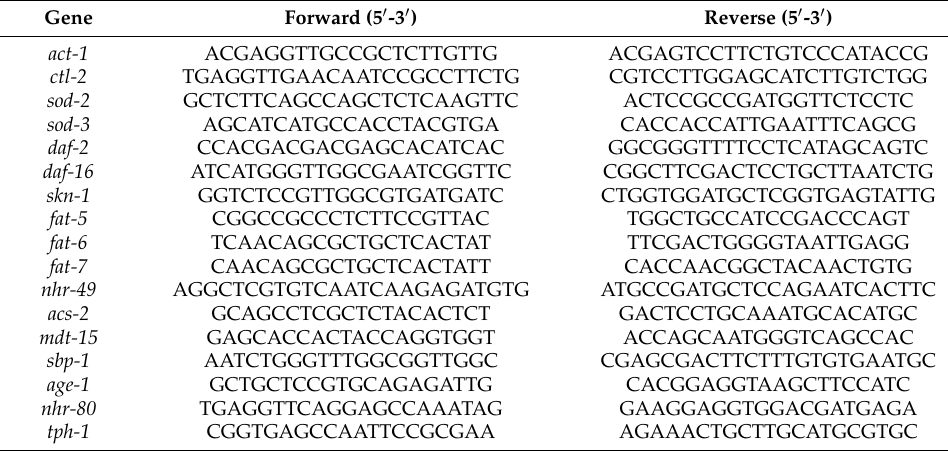
Table 2. Sequences of primers used in the gene expression analysis.